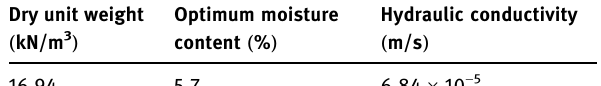
Table 1: Physical properties of soil Dry unit weight ( kN/m 3 )